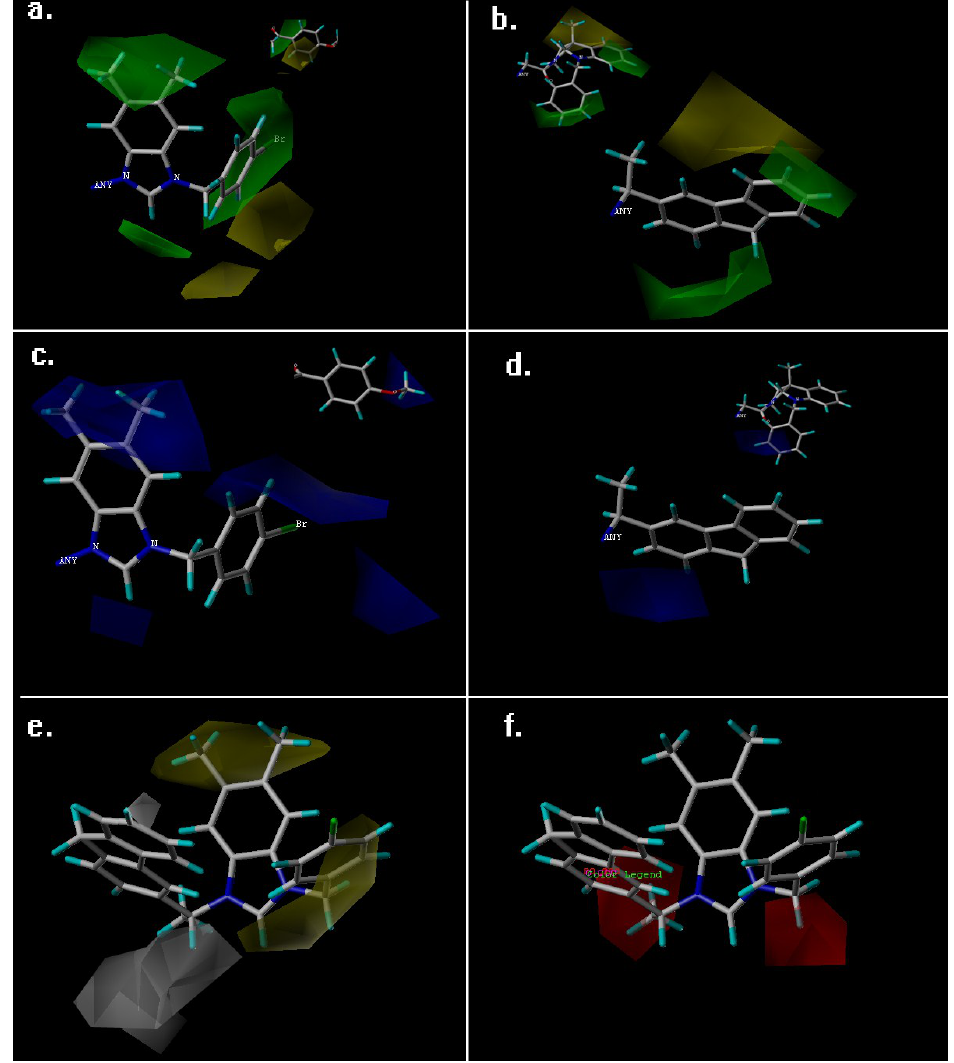
Figure 3. Contour maps of the results of topomer CoMFA and CoMSIA. ( a , b ) Topomer CoMFA steric contour maps of fragment 1 and 2, the green and yellow regions indicate the sterically favorable and unfavorable regions, respectively; ( c , d ) Topomer CoMFA electrostatic contour map of fragment 1 and 2, the blue and red regions are favorable to positively and negatively charged substituents, respectively; ( e ) CoMSIA hydrophobic contour map, the yellow and white regions are favorable and unfavorable to hydrophobic substituent groups, respectively; ( f ) CoMFA hydrogen bond acceptor field, magenta and red indicate regions favorable and unfavorable to hydrogen bond acceptor (HBA) atoms, respectively.